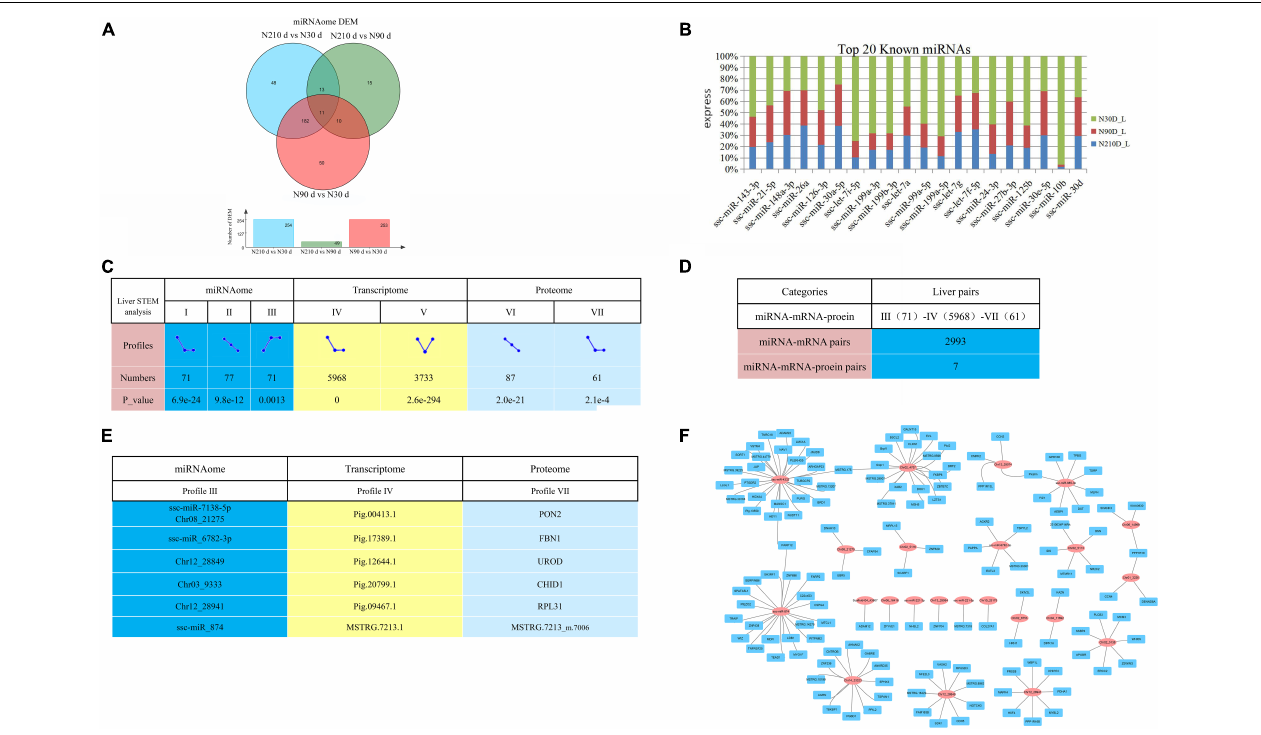
FIGURE 6 | Overview of possible negative miRNA–mRNA–protein interactions. (A) The Venn diagram of DEMs at three comparison groups. (B) Top 20 known miRNAs expressed in liver. (C) STEM analysis of miRNA, transcriptome, and proteome. And count the number and P -value of miRNA/mRNA/protein enriched in each profile. (D) The numbers of possible negative miRNA–mRNA/miRNA–mRNA–protein interactions based on STEM analysis expression patterns. (E) The information of seven potential miRNA–mRNA–protein interaction pairs based on STEM analysis. (F) Part of the miRNA–mRNA negative correlation network based on 2993 profile (III)–profile (IV) expression patterns. Red circles indicate miRNAs, Blue rectangle indicate coding